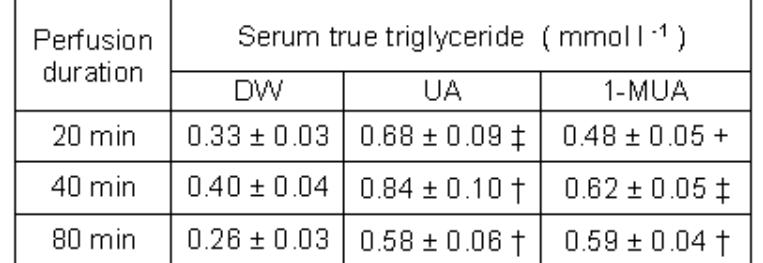
Serum True Triglyceride Levels Following Perfusion of the Urinary Bladder with DW or UA or 1-MUA at 20, 40, and 80 min